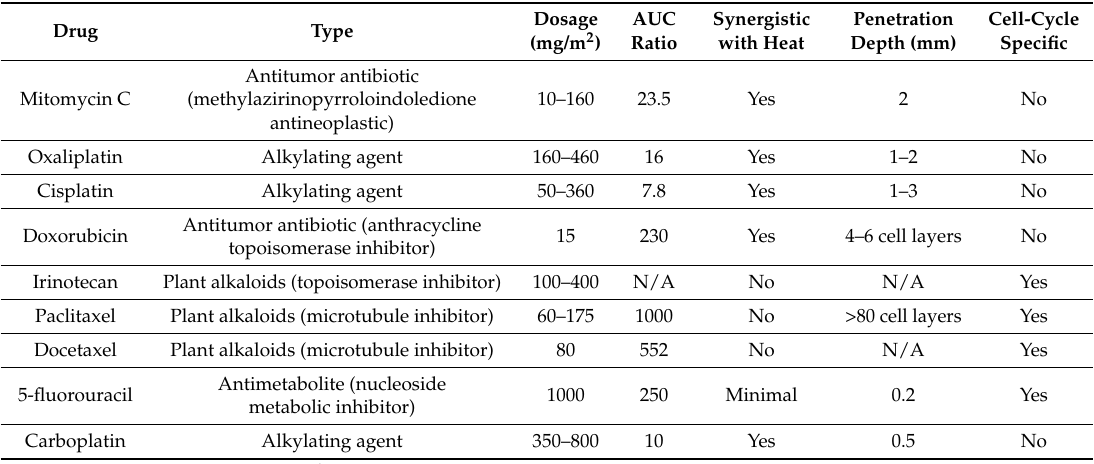
Table 1. Cytotoxic drugs used for HIPEC (adapted from Kusamura et al., 2008 [26]). Dosage based on literature search (see Supplementary